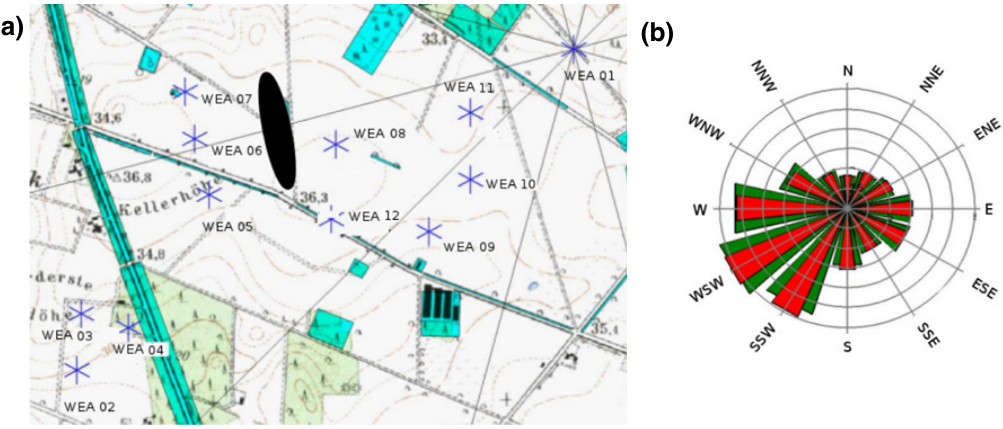
Figure 1. (a) Wind park Krumlande. The location of the wind turbines (WEA) is indicated by blue asterisks. The position of the landfill is indicated by a black elipse. (b) Wind conditions at the site Krumlande, 50 m height. The frequencies for each direction are presented in Table 1. (Adapted from